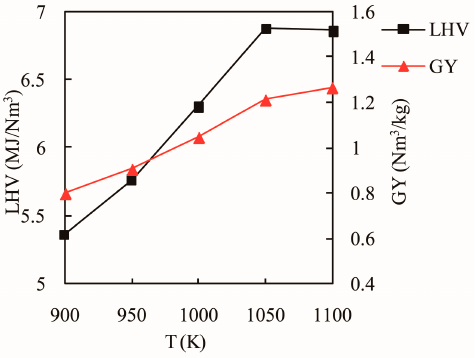
Figure 8. Effects of gasification temperature on LHV and GY at ER = 0.2 and SBR = 0.3.